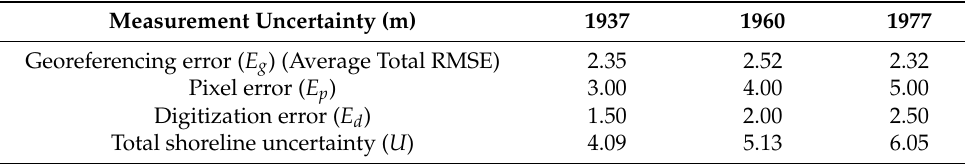
Table 3. Estimated total shoreline uncertainty for each of the historical aerial